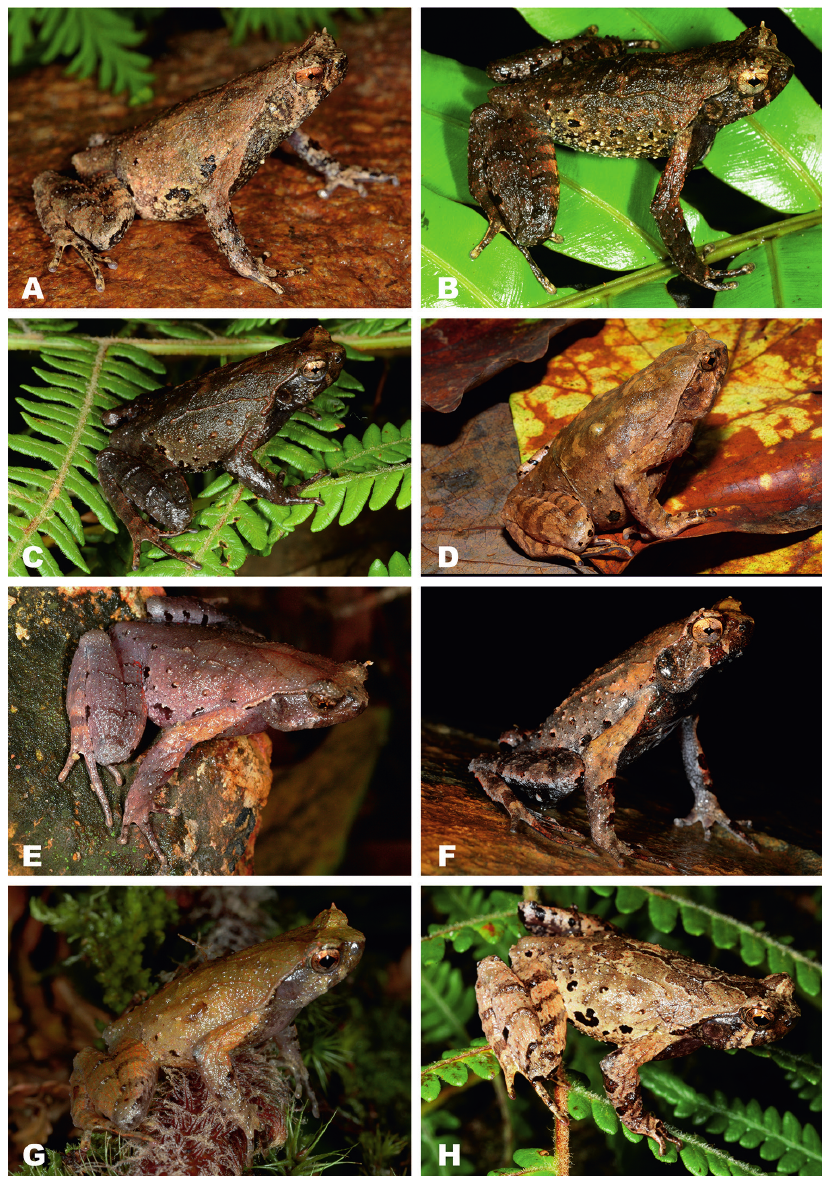
Figure 6. Ophryophryne species of the Langbian Plateau (Vietnam): A O. gerti , female, Chu Yang Sin N.P., Dak Lak Prov., 1000 m a.s.l. B O. gerti , male, Chu Yang Sin N.P., Dak Lak Prov., 1000 m a.s.l. C O. gerti , male, Bidoup–Nui Ba N.P., Lam Dong Prov., 1550 m a.s.l. D O. synoria , female, Bu Gia Map N.P., Binh Phuoc Prov., 400 m a.s.l. E O. synoria , male, Chu Yang Sin Mt., Chu Yang Sin N.P., Dak Lak Prov., 1000 m a.s.l. F O. synoria , male, Bidoup–Nui Ba N.P., Lam Dong Prov., 1550 m a.s.l. G